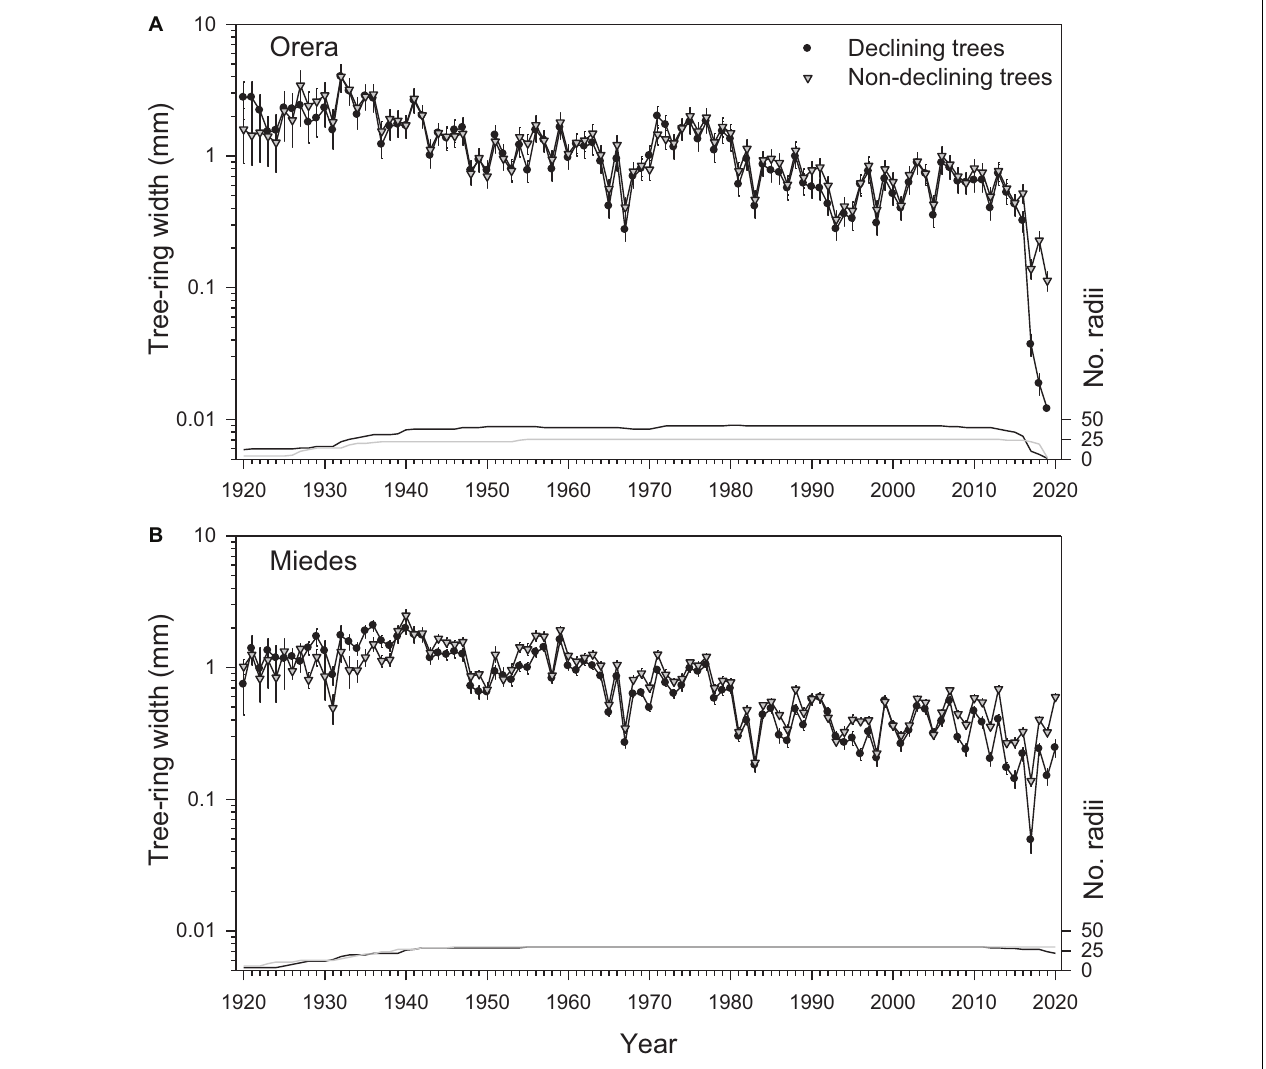
FIGURE 2 | Long-term radial-growth patterns of D (black circles) and ND (gray triangles) trees in the (A) Orera and (B) Miedes study sites. Values are means SE (note the logarithmic scales in the left Y -axis). The number of measured radii (lines) is shown in the right Y